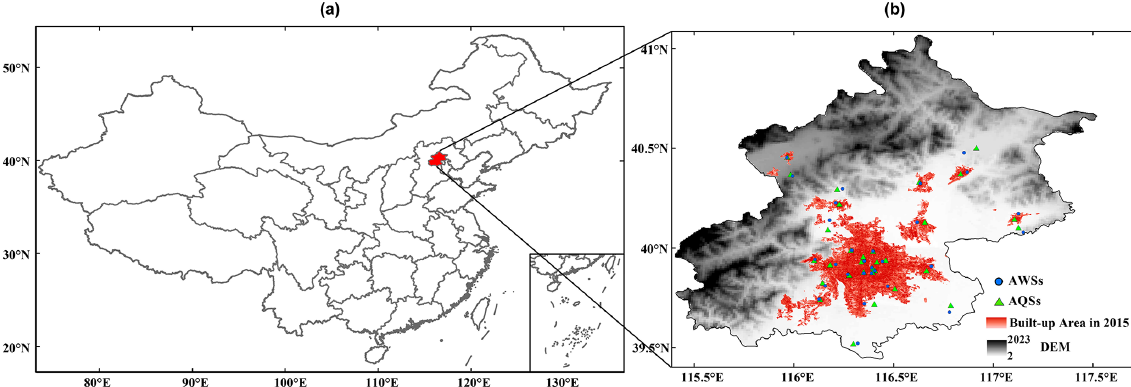
Figure 1. (a) Geography of Beijing. (b) Distribution of AWSs and AQSs in Beijing (superimposed on the built-up area data for 2015 from digital elevation model